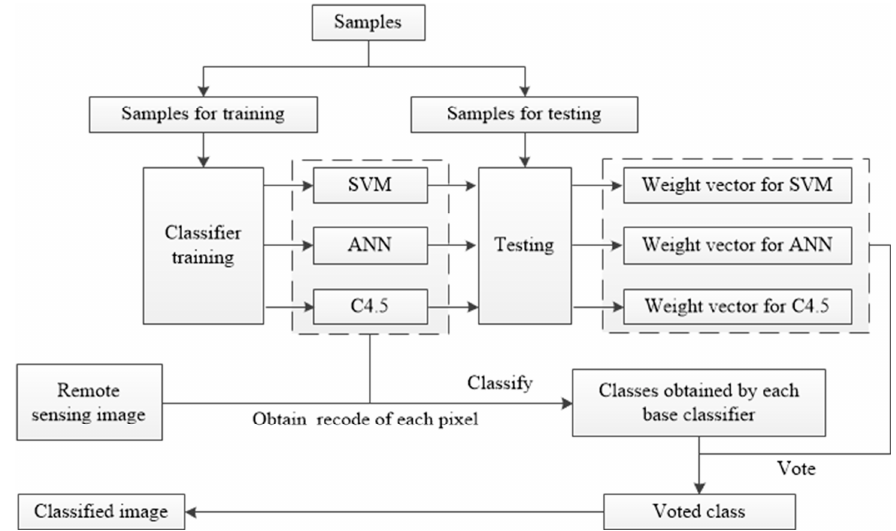
Figure 3. Diagram of MCS_WV (multiple classifiers system based on weight vector) classification.